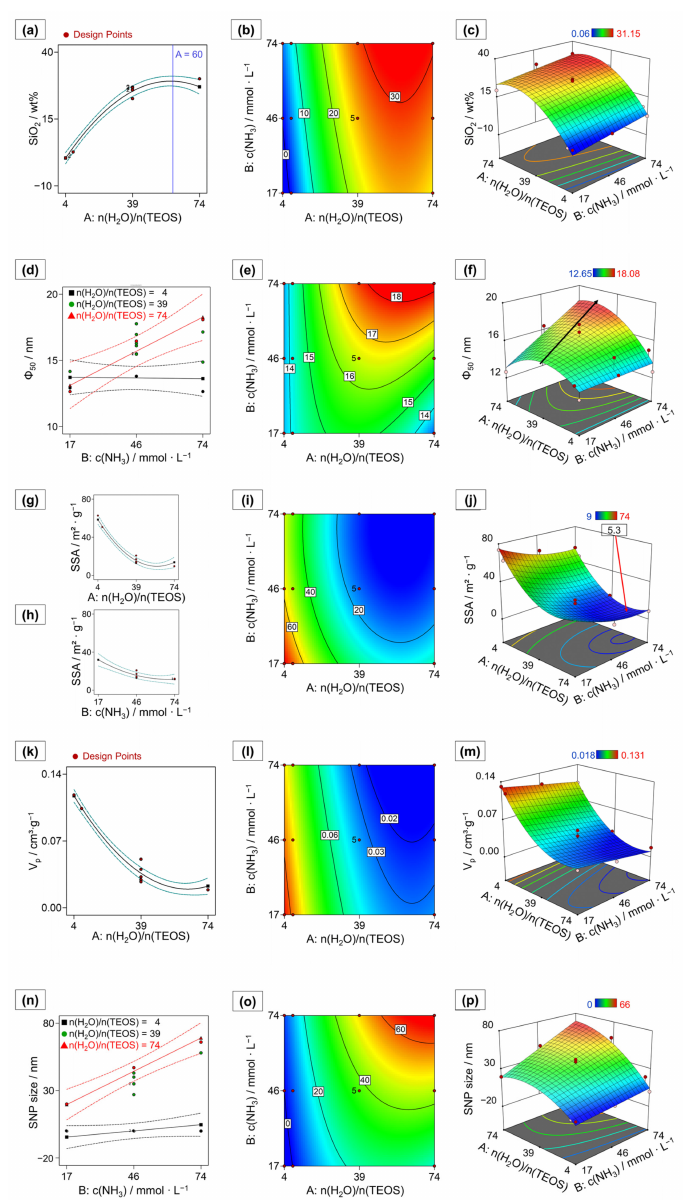
Figure 2. Overview over all relevant model graphs–one factor effect plots, depicting the effect of a single factor on the response at a medium level of the other studied process factor ( a , g , h , k ); interaction plots showing the dependence of the response on the settings of the two synergistically interacting factors ( = low setting, = medium setting, = high setting) and visualizing the strengths of the synergistic interactions ( d , n ); contour plots displaying a heatmap for each response variable dependent on both process factors ( b , e , i , l , o ); response surface plots showing the values for the responses predicted by the response surface model across the design space for each combination of process factor settings ( c , f , j , m , p ). Note that, in the 3D-plots ( j , m ), the axes of n(H 2 O)/n(TEOS) are given in opposite direction to ( c , f , p ) for better visibility. Dashed lines indicate 95% confidence intervals for one factor and interaction plots. Red areas correspond to high and blue areas correspond to low response values in the response surface models. The responses are as follows: ( a – c ) SiO 2 content, blue line indicates maximum SiO 2 deposition; ( d – f ) median pore size ( φ 50 ), the black arrow indicates a shift in maximal φ 50 across the design space; ( g – j ) specific surface area (SSA) with the minimal SSA within the experimental space indicated by a flag; ( k – m ) pore volume (V p ); ( n – p ) SNP